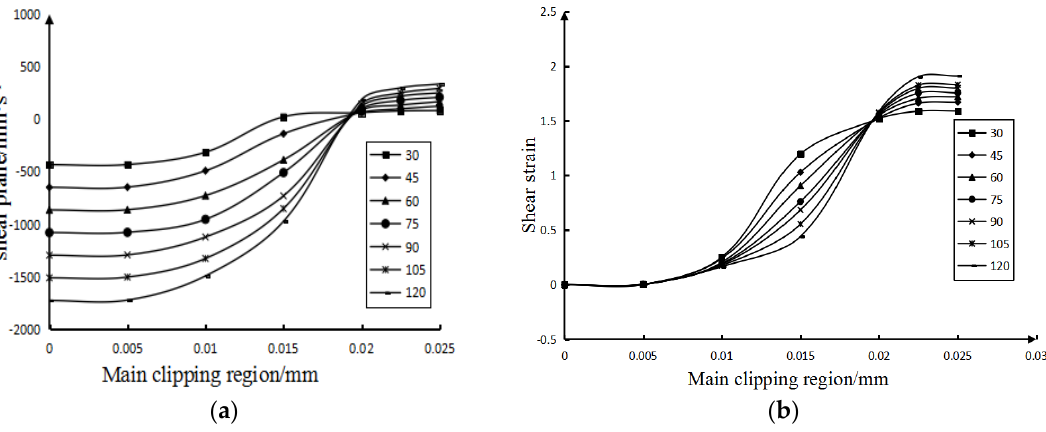
Figure 3. The influence of cutting speed. ( a ) The influence of cutting speed on the tangential velocity along the shear plane. ( b ) The influence of cutting speed on shear strain. along the shear plane. ( b ) The influence of cutting speed on shear